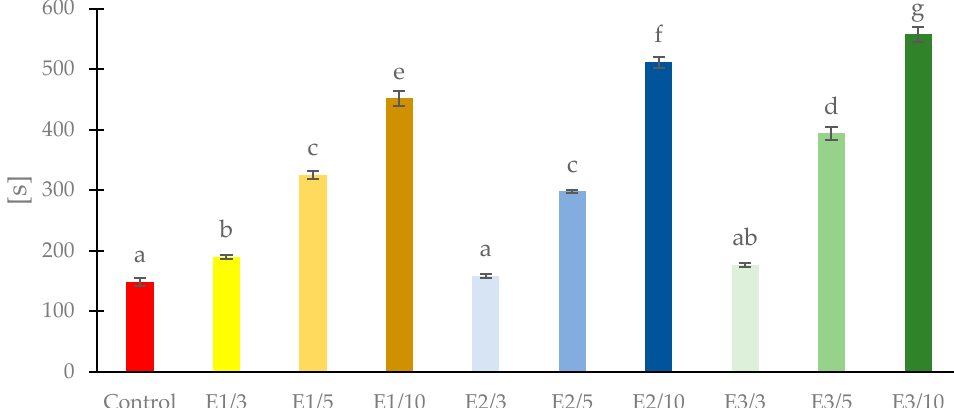
Figure 2. Time of water solubility of pullulan films with propolis extract. Different letters (a–g) above the columns indicate significant differences ( p < 0.05).